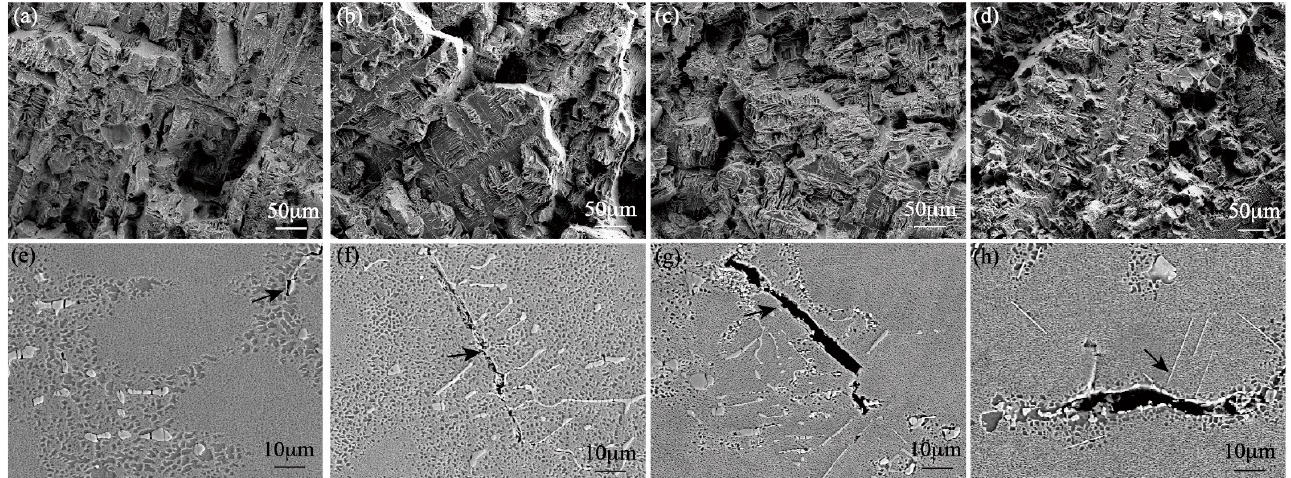
Figure 8. SEM images of tensile fracture surfaces and the longitudinal microstructure at room tem- perature: ( a , e )Alloy I, ( b , f ) Alloy II, ( c , g ) Alloy III, ( d , h ) Alloy IV.